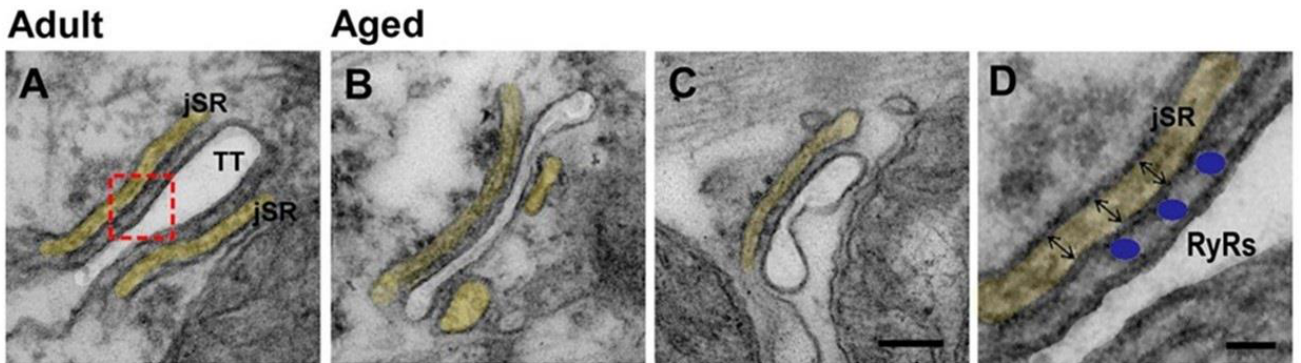
Table 1. Quantitative analysis of PCs, CRUs, and of not properly positioned CRUs (at the A-band or longitudinally oriented).